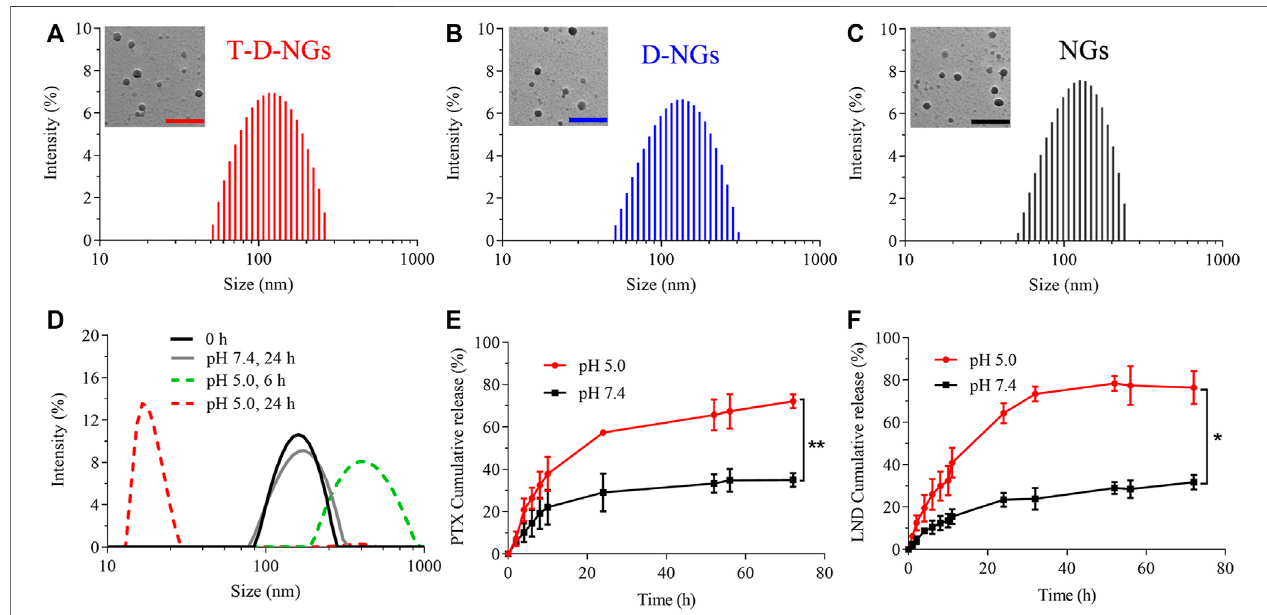
FIGURE 2 | Size distribution of (A) T-D-NGs, (B) D-NGs, and (C) NGs determined by DLS and TEM (inset). Scale bars: 500 nm. (D) pH-triggered size variation of T-D-NGs for different times (0, 6, and 24 h) determined by DLS. In vitro (E) PTX and (F) LND release from T-D-NGs (2 mg/ml) at 37 ° C ( n (cid:2) 3, * p < 0.05, ** p < 0.01). DLS, dynamic light scattering; TEM, transmission electron microscopy; PTX, paclitaxel; LND, lonidamine.